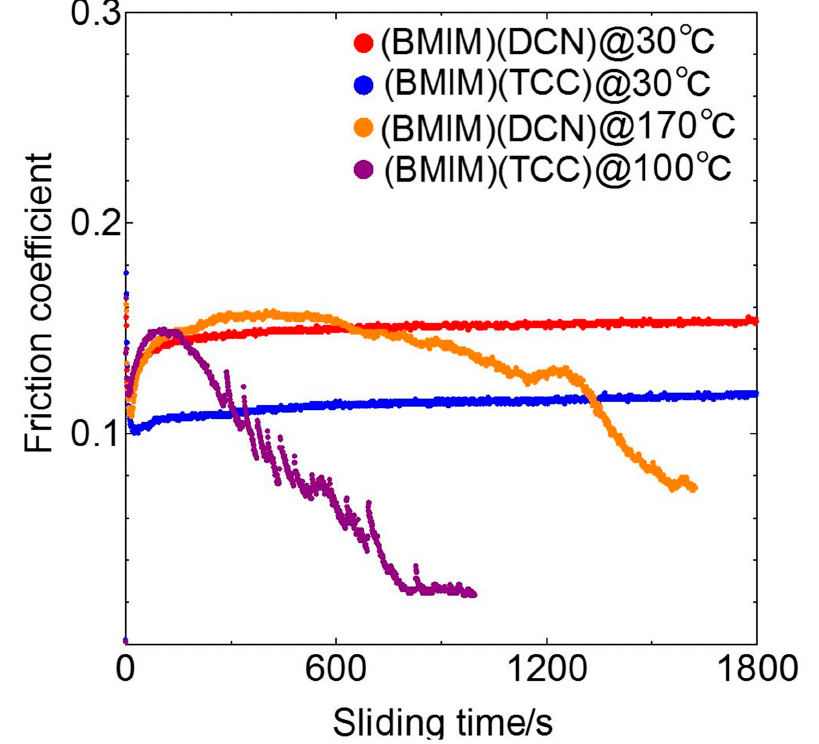
Figure 2. Frictional behavior of (BMIM)(DCN) and (BMIM)(TCC) at each temperature.